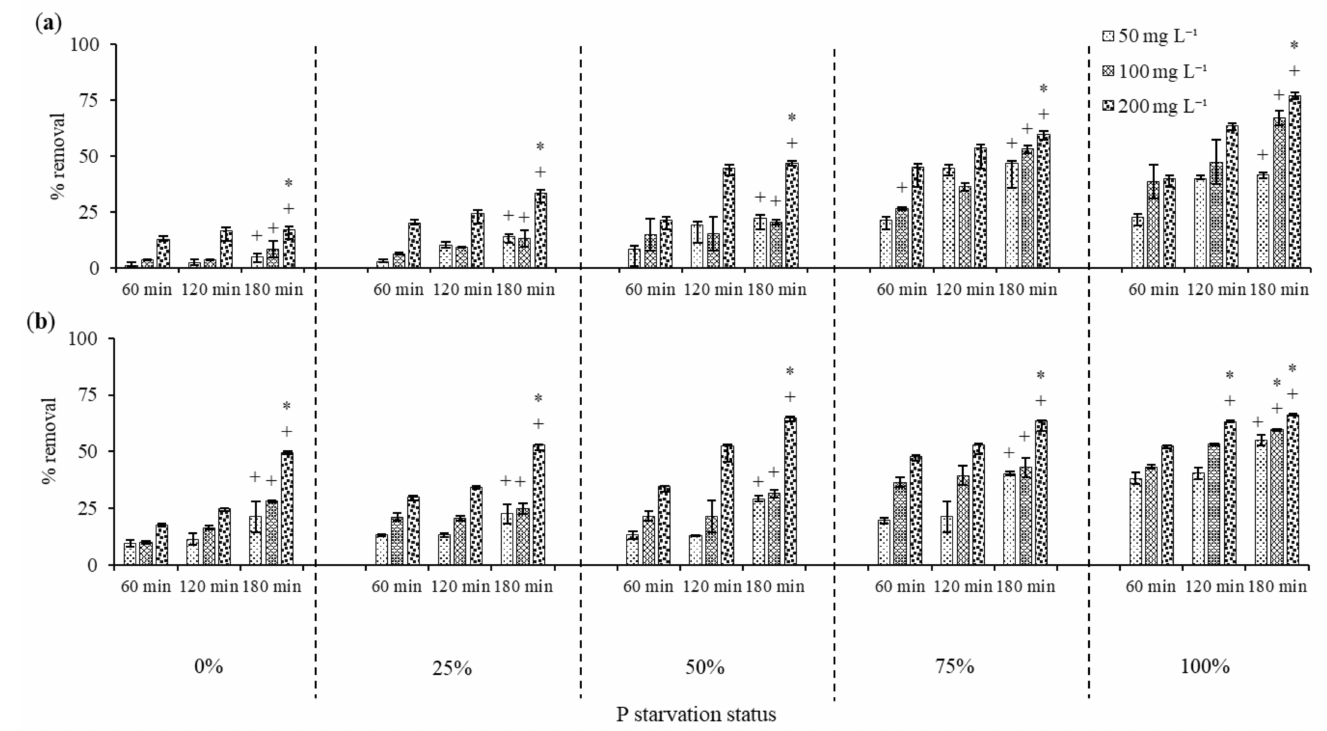
Figure 2. Percent removal of phenol by C. vulgaris dried biomass starved with 0, 25, 50, 75, 100% phos- phorus and acid treated further at ( a ) 100 mg L − 1 and ( b ) 200 mg L − 1 phenol exposure. In all cases, p < 0.05 and n = 3 ± SE. + on bars, within each phosphorus starvation status (0, 25, 50, 75, or 100%), represents the highest significant phenol removal at the specific time of exposure (60, 120, or 180 min) with the same concentration of biomass (50, 100, or 200 mg L − 1 ), while * on the bar represents the highest significant phenol removal within all observations.